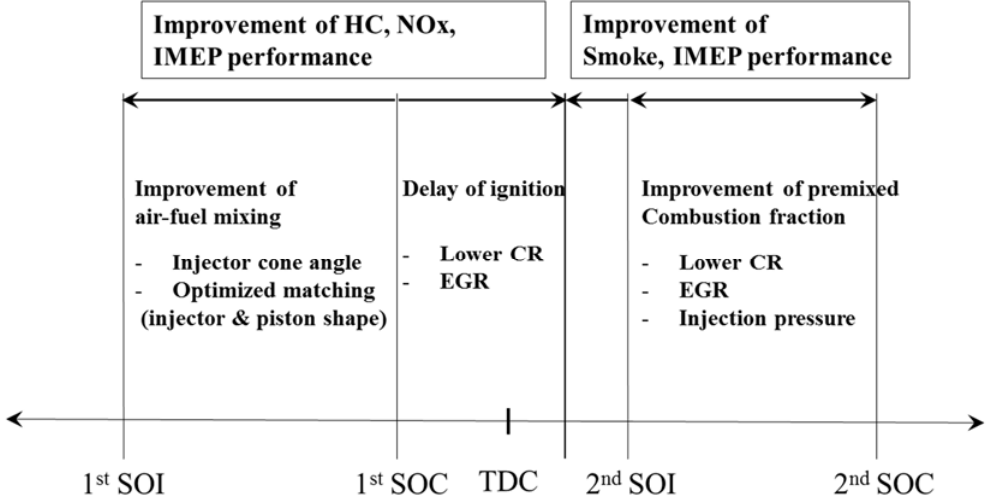
Figure 4. Engine performance improvement of the multiple injection method.